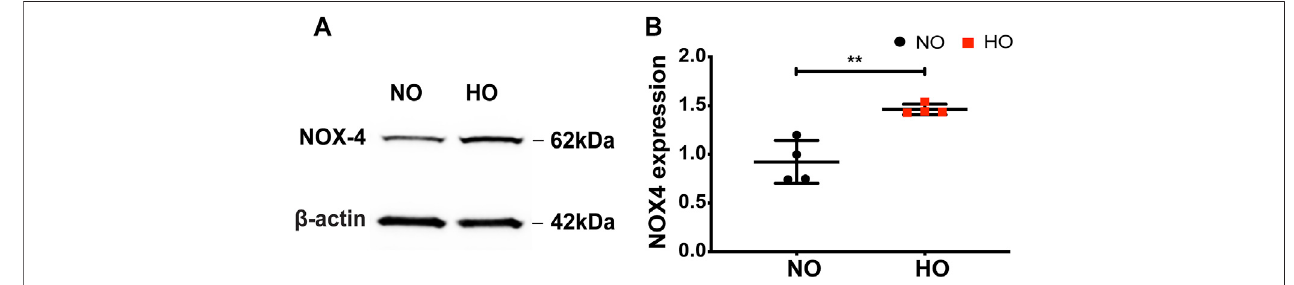
FIGURE 7 | HO induces NOX4 expression in lung epithelial cells. (A) MLE-12 cells were exposed to NO or HO and total cell lysates were subjected to Western blotting with anti-NOX4 antibody. Increased expression of NOX4 was observed in the HO group compared to NO (B) Densitometric quanti fi cation of NOX4. The data were normalized to GAPDH. n = 4. ** p < 0.01 and * p < 0.05.